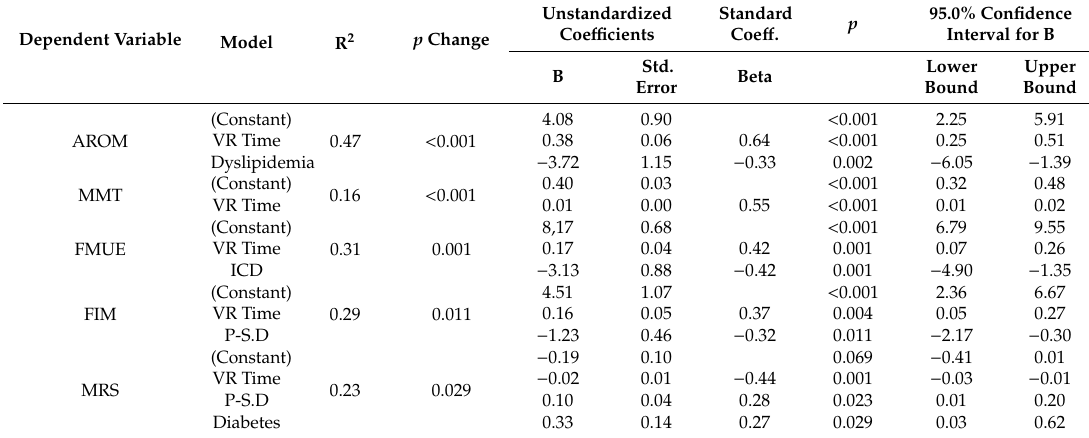
Table 5. Multiple linear regression results.